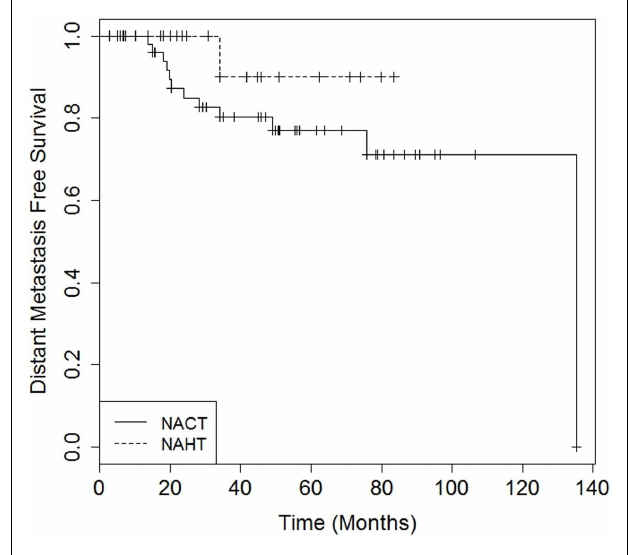
FIGURE 1 | Kaplan–Meier curves illustrating distant metastasis free survival over time for patients receiving neoadjuvant hormonal